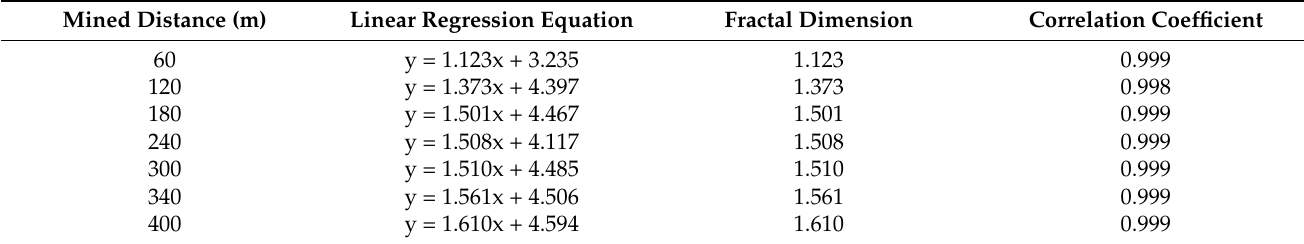
Table 2. Calculation of fractal dimension of fractures with mined